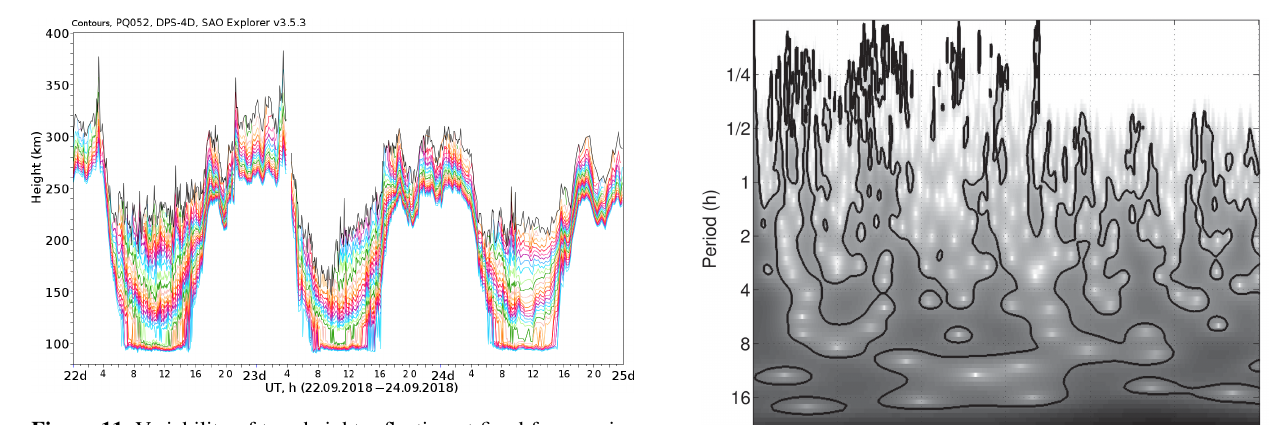
Figure 11. Variability of true-height reflection at fixed frequencies recorded during 22–24 September for the frequency range 2–6MHz with a 0.1MHz step, in a standard DPS-4D format.